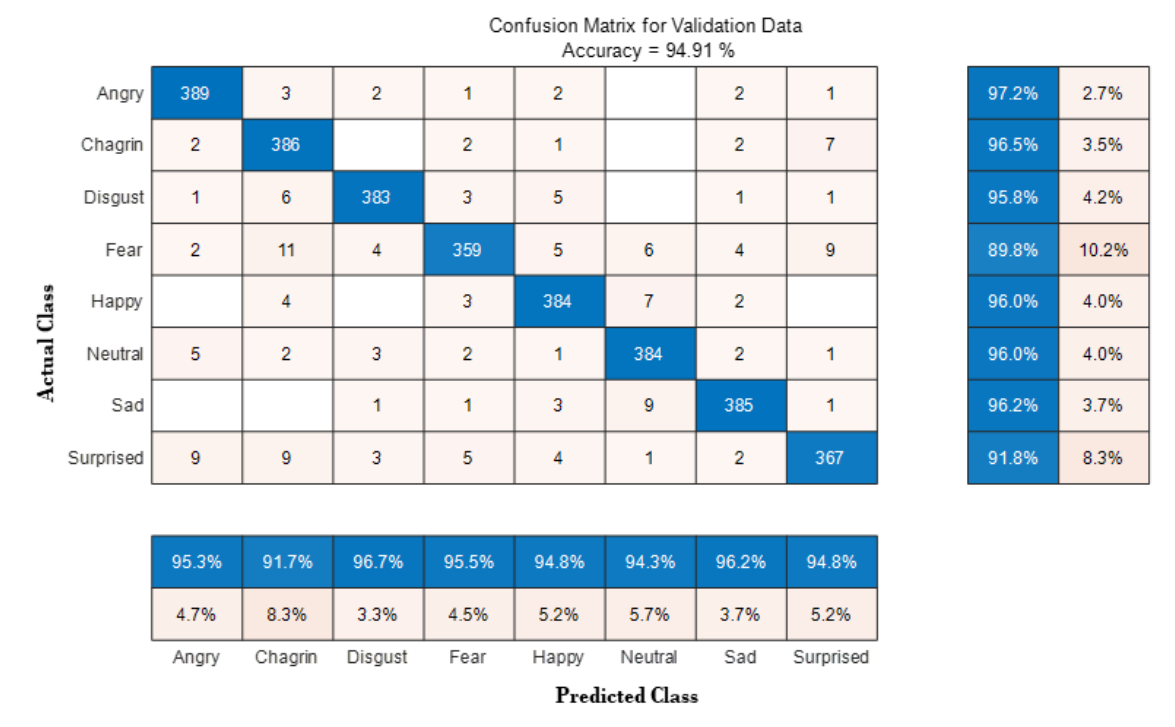
Figure 9. Confusion matrix of YAMNet SER model.